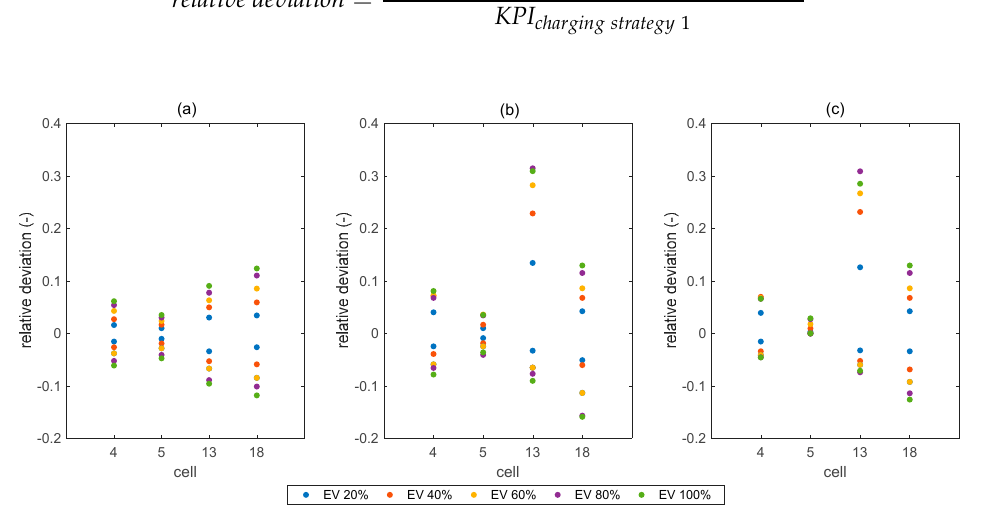
Figure 24. Maximum and minimum relative deviation of selected cells for a fixed penetration of 60% PV and a variation of the penetration of EV for 3.7 kW charging power ( a ) DSG ( b ) DSS ( c ) SCR.